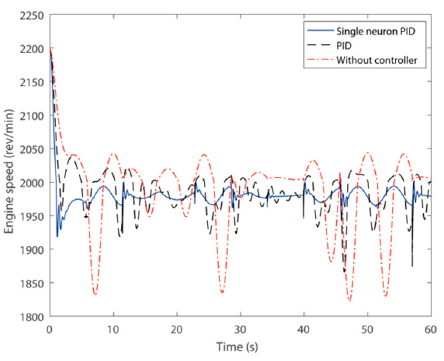
Figure 6. The engine speed curves.